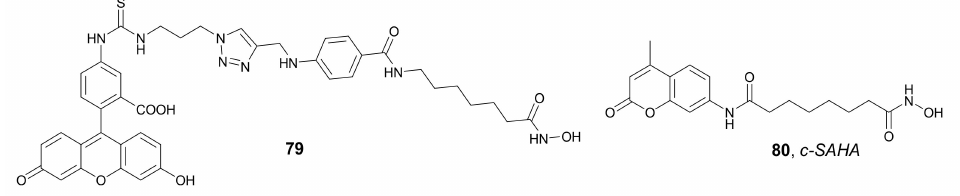
Figure 27. Chemical structures of compounds 79 and 80